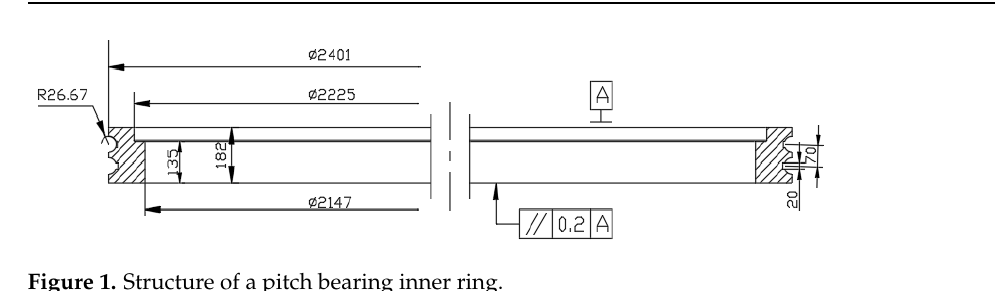
Figure 1. Structure of a pitch bearing inner ring.